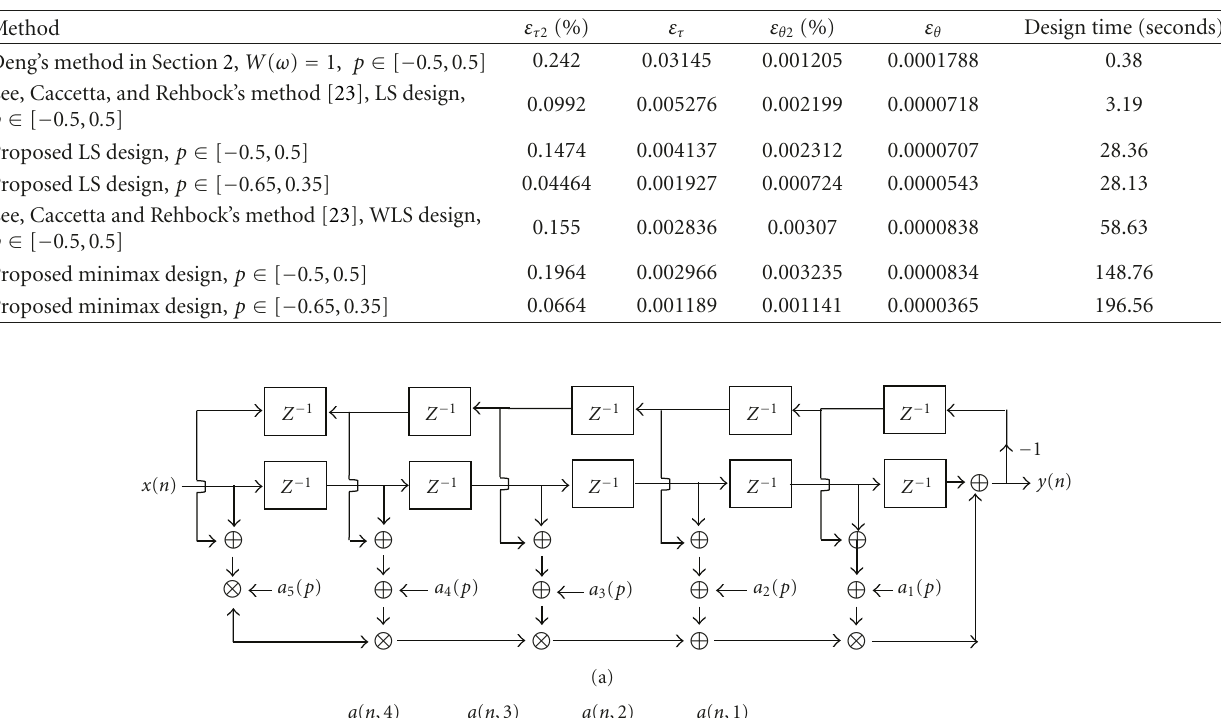
Table 1: Comparison of evaluated errors in (29).